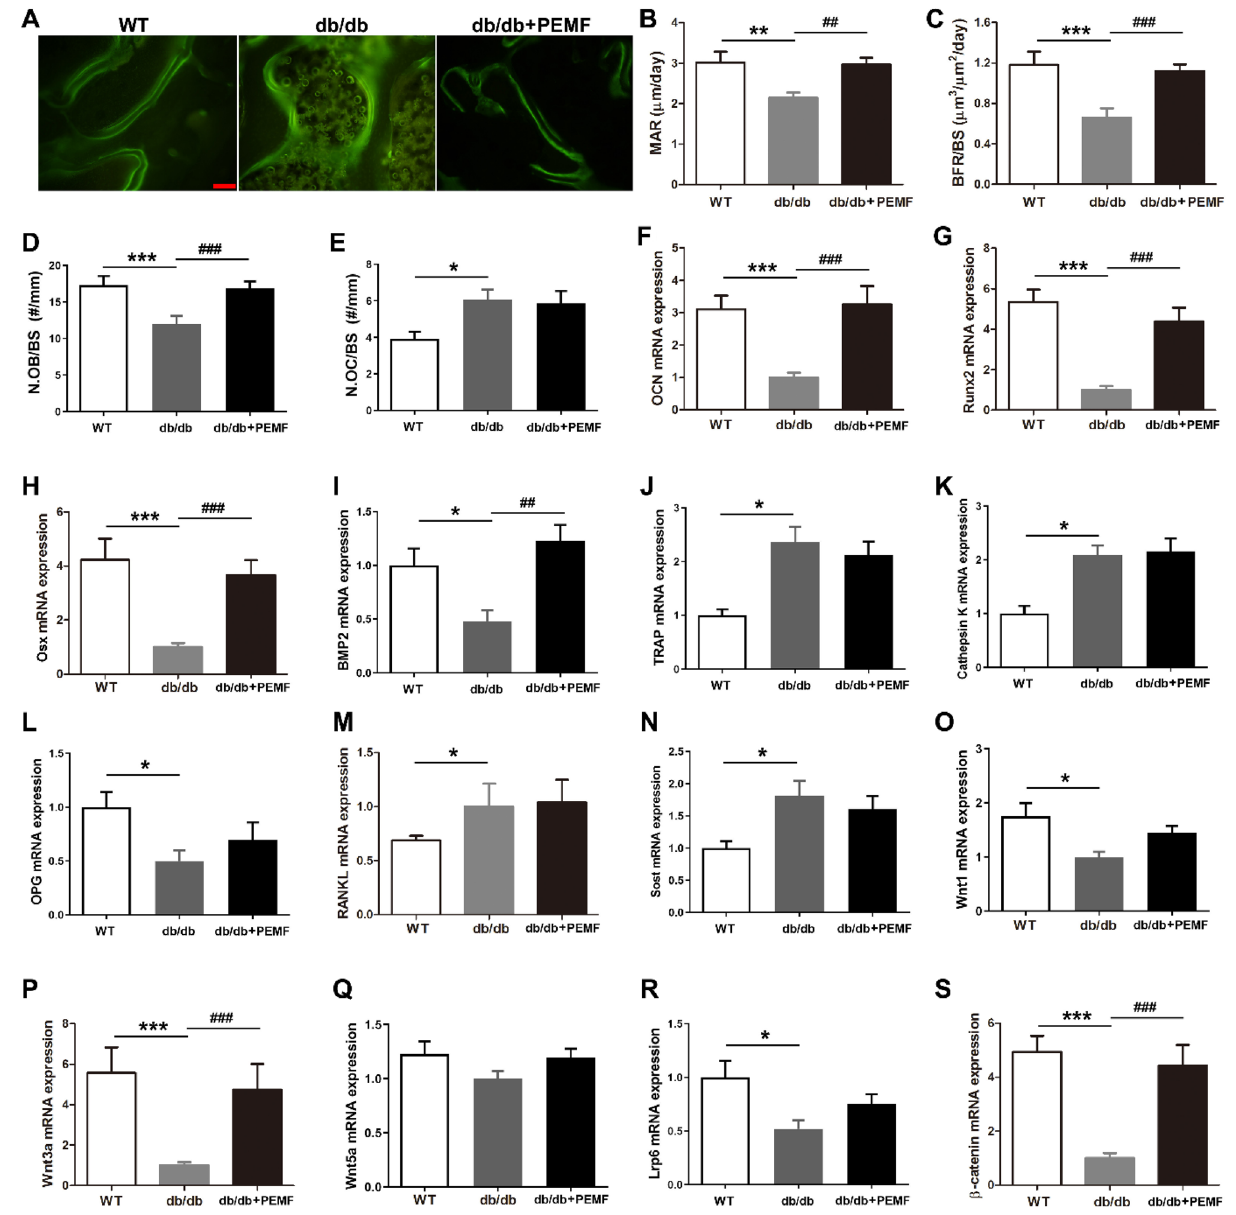
Figure 2. Pulsed electromagnetic fields (PEMF) exposure for 12 weeks increases in vivo bone formation, up-regulates the expression of osteoblastic differentiation-related genes, and stimulates the expression of canonical Wnt signaling genes in mandibular bone of type 2 diabetic db/db mice. ( A ) Representative calcein double-labeling images in mandibular trabecular bone surfaces. Scale bar represents 100 µm. (B,C) Statistical comparison of calcein double-labeling data, including (B) mineral apposition rate (MAR) and (C) bone formation rate per bone surface (BFR/BS). (D,E) Static bone histomorphometry to quantify osteoblast numbers per millimeter of trabecular bone surface (N.OB/BS) and osteoclast numbers per millimeter of trabecular bone surface (N.OC/BS) in mandibular specimens. (F–N) Analysis of mandibular bone gene expression associated with osteoblastic differentiation (including osteocalcin, Runx2, Osx and BMP2), osteoclastogenesis (TRAP, Cathepsin K, OPG and RANKL) and osteocyte-specific marker (Sost). (O–S) Analysis of mandibular bone gene expression of canonical Wnt1 and Wnt3a ligands, non-canonical Wnt5a ligand, transmembrane protein Lrp6, and downstream β-catenin of canonical Wnt signaling. Data are represented as mean ± SEM ( n = 9/group). * P < 0.05, ** P < 0.01, *** P < 0.001 vs. the WT group; ## P < 0.01, ### P < 0.001 vs. the db/db group by one way analysis of variance (ANOVA) followed by Bonferroni’s multiple